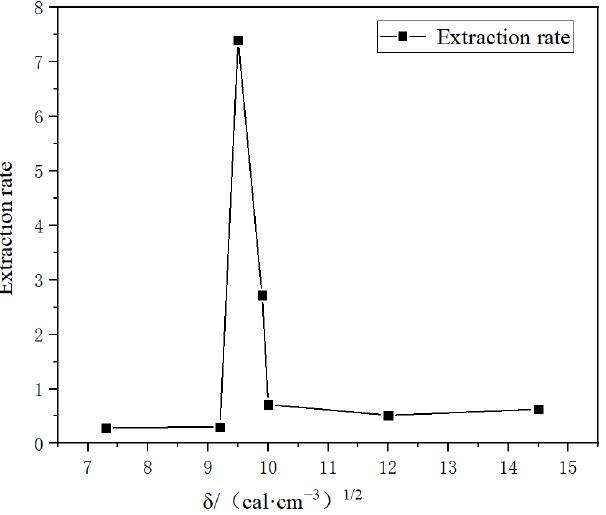
Figure 2. Variation of extraction rate of Shenfu coal with extractant solubility parameters.